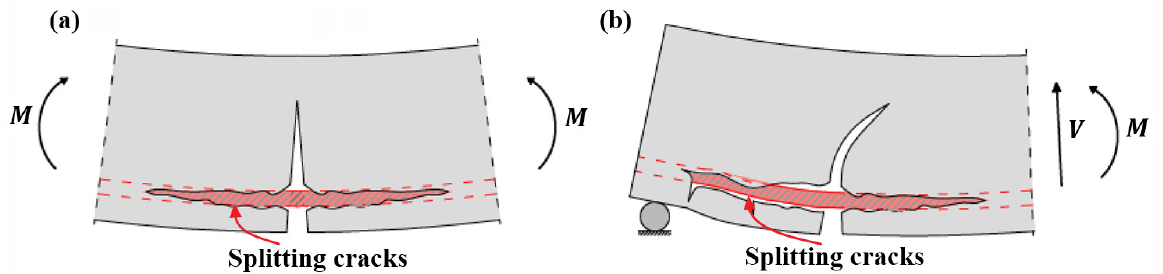
Figure 6. Typical formation locations of splitting cracks: ( a ) the maximum moment region; and ( b ) the end of RC beams end of RC